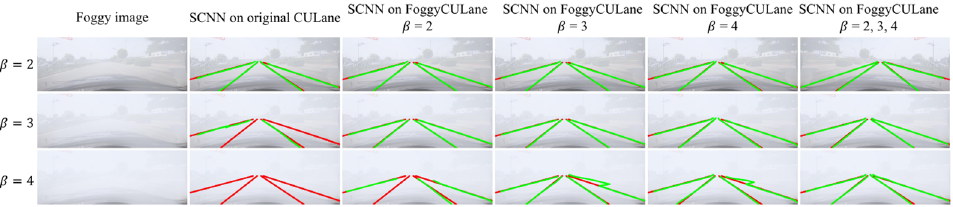
Figure 6. The foggy lane detection results of SCNN trained on different datasets show the real lane markings in red and the predicted lane markings in green.